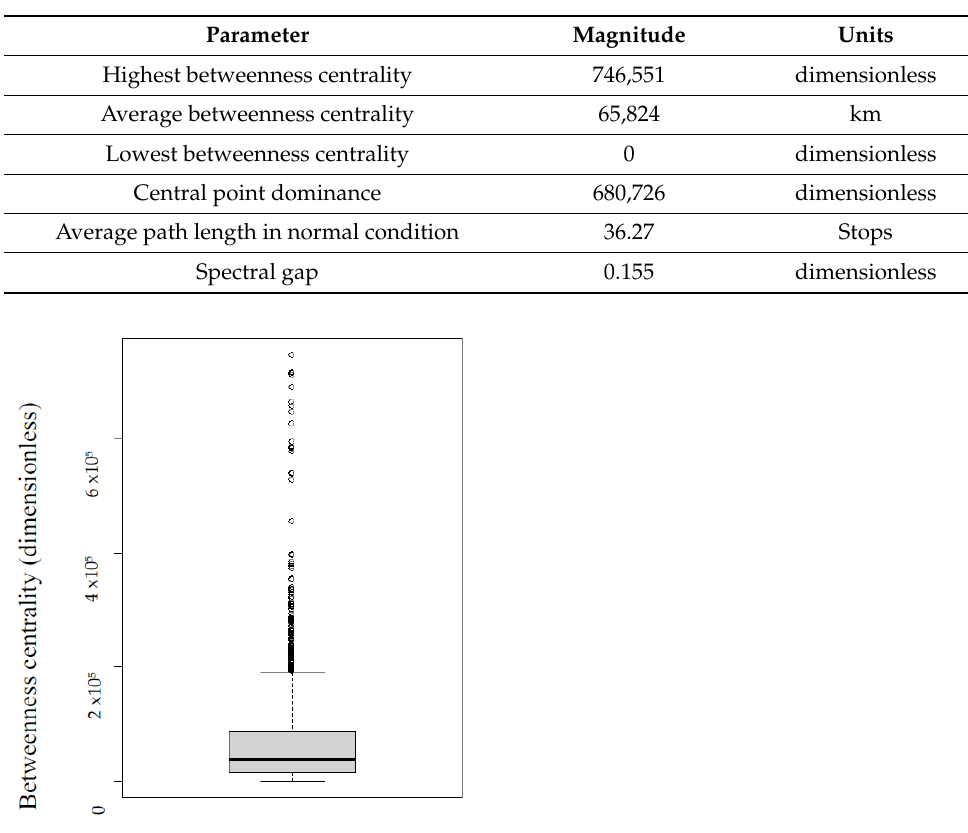
Figure 10. Boxplot of the betweenness centrality distribution.